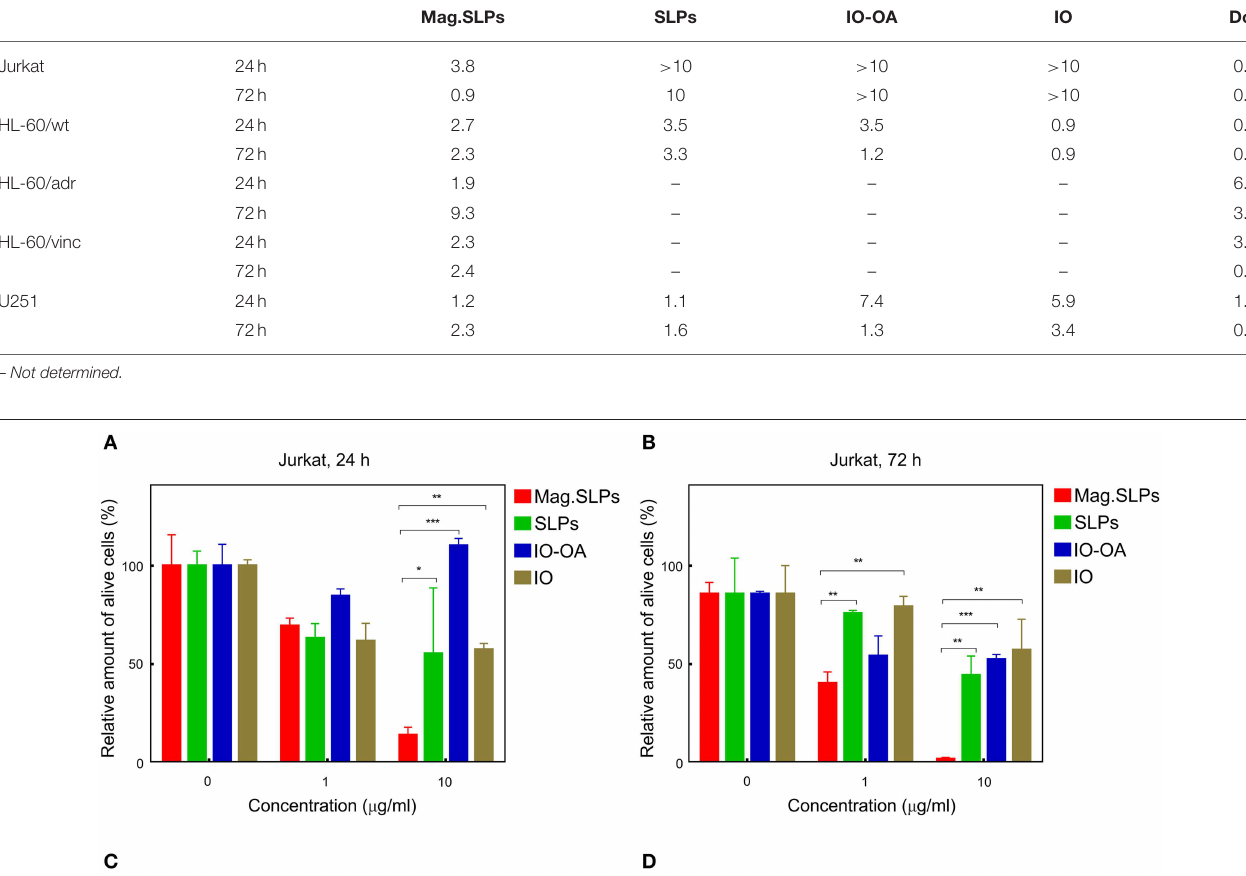
particles. The technique is based on fluorescent dyes, DCFDA and DHE, for detecting H 2 O 2 and superoxide anion radicals (O 2 − ), respectively. When Jurkat cells were treated with the mag.SLPs, SLPs, IO-OA, and IO particles, only the mag.SLPs induced both H 2 O 2 and O 2 − production ( Figure 6 ). to higher concentration of H 2 O 2 , was observed at both